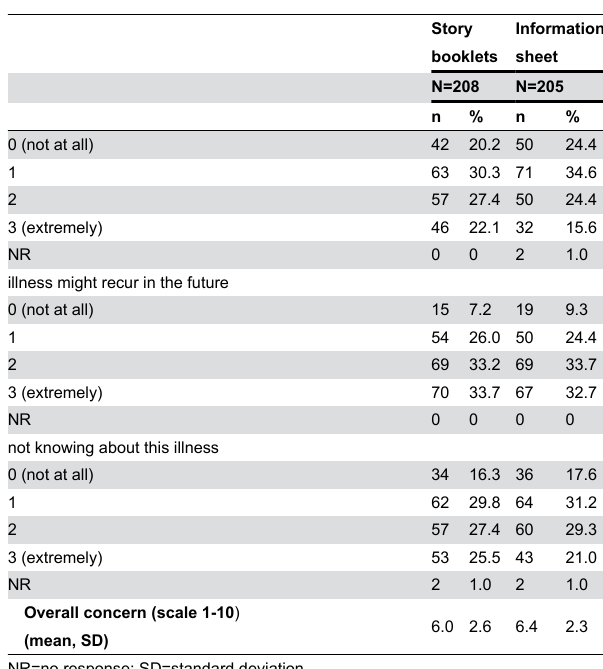
Table 3. Parental concern at